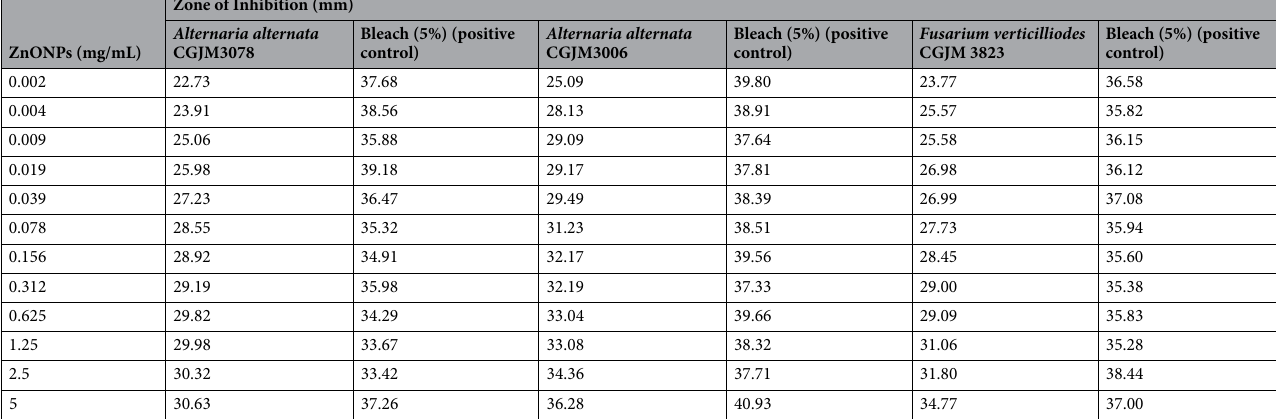
Table 5. Antifungal activities (in vitro) of ZnONPs against the filamentous fungi Alternaria alternata (CGJM3078 andCGJM3006) and Fusarium verticilliodes CGJM 3823 are indicated in the form of inhibition zone sizes for each concentration of ZnONPs treatment. Bleach served as the positive control that exhibited similar diameter in their zones of inhibitions. The negative controls all did not show any